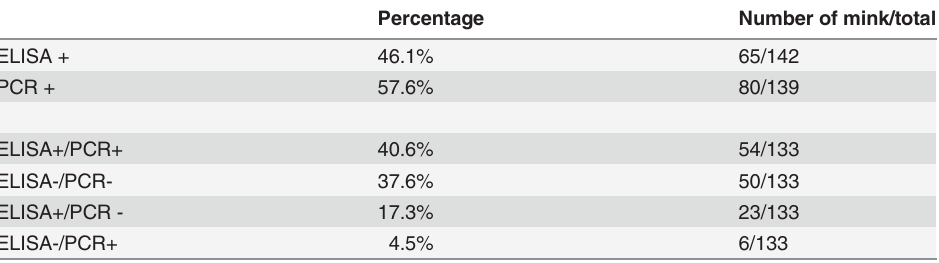
Table 1. Percentage of positive and negative mink for detection of AMDV antibodies (ELISA) or AMDV DNA